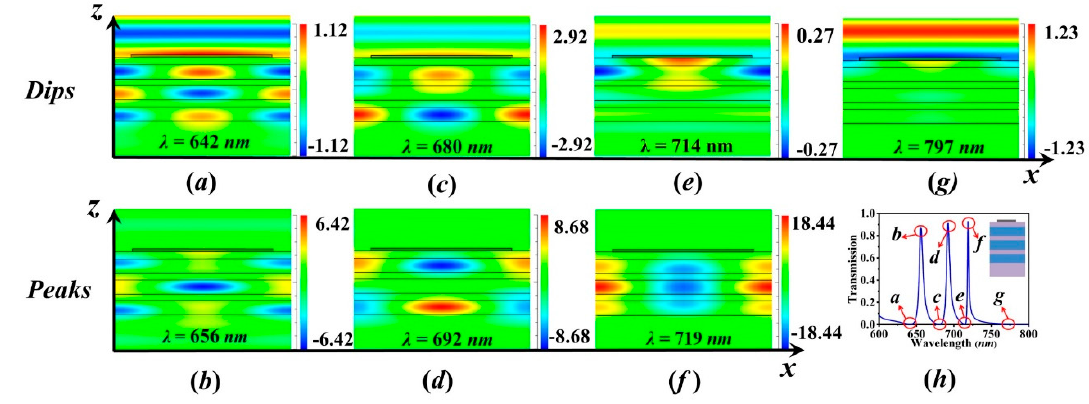
Figure 3. Magnetic distributions ( H y ) for structure with N = 3, p = 400 nm, w = 320 nm, t = 40 nm, t L = 100 nm, t H = 200 nm, n L = 1.5, n H = 2 at the resonant dips ( a ) λ = 642 nm, ( c ) λ = 680 nm, ( e ) λ = 714 nm, ( g ) λ = 797 nm and peaks ( b ) λ = 692 nm, ( d ) λ = 692 nm, ( f ) λ = 719 nm in the ( h ) transmission spectrum.